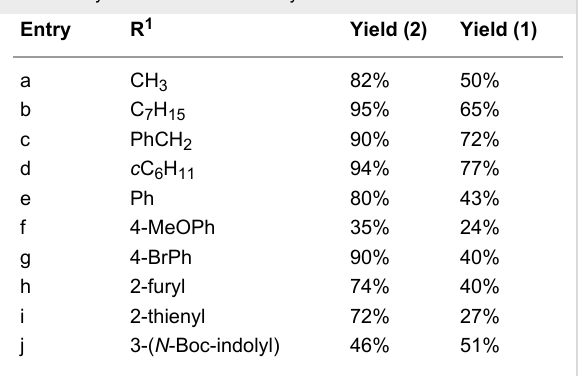
Table 1: Synthesis of substituted silylketenes 1 Entry